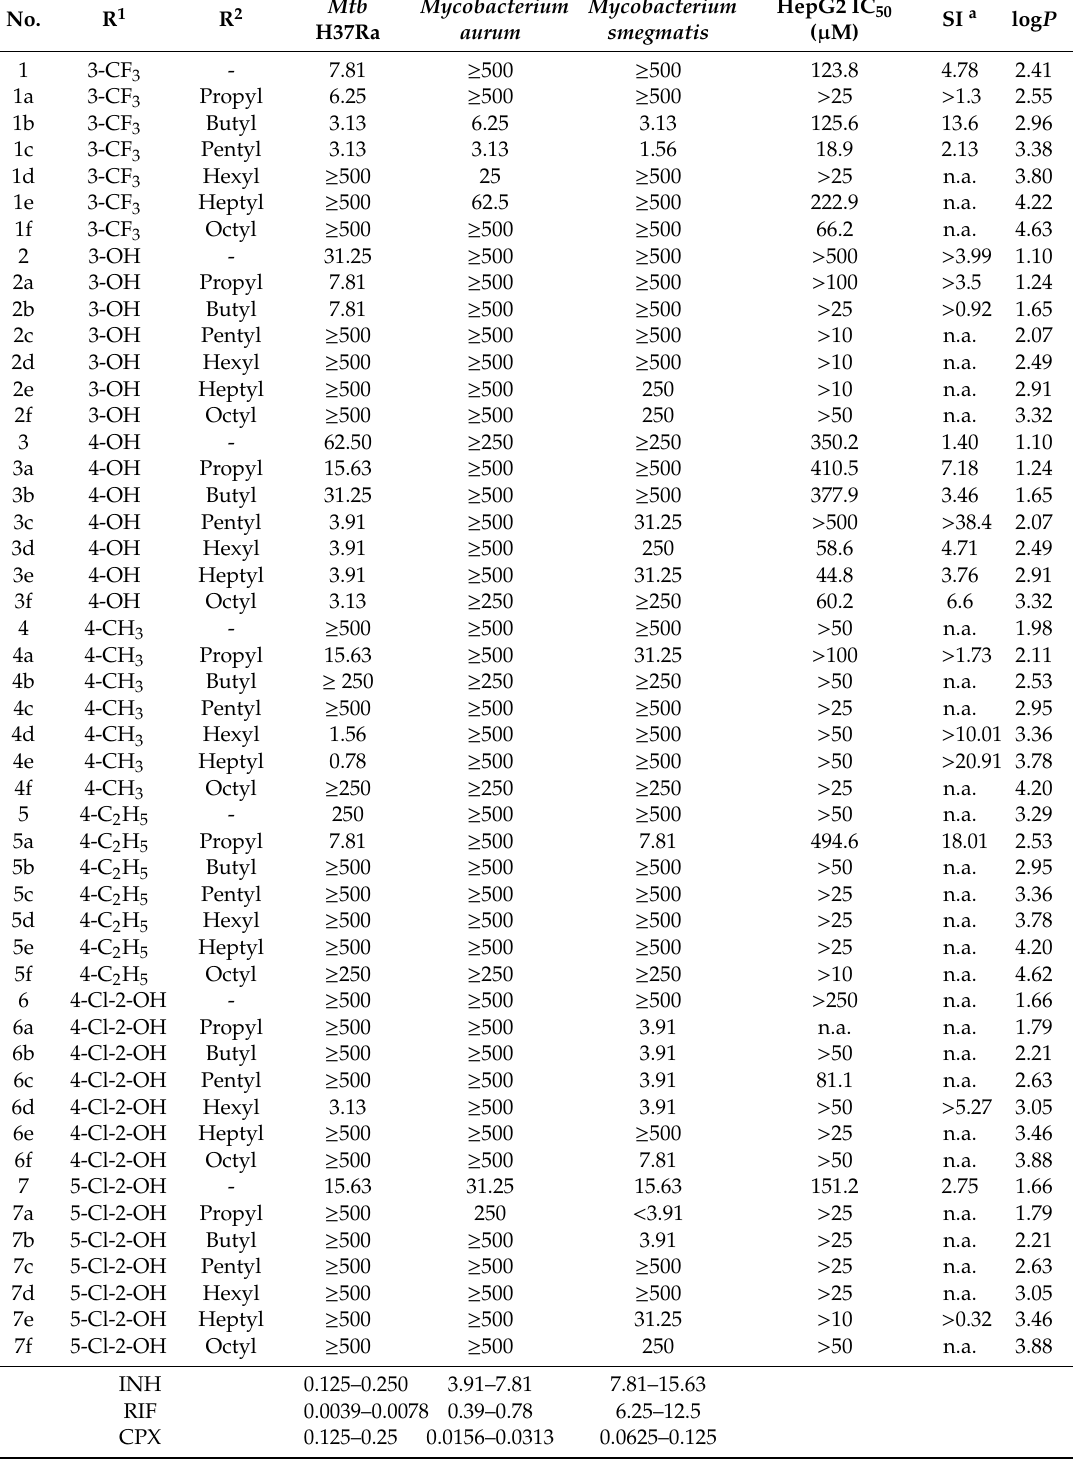
Table 1. In vitro antimycobacterial activity against Mtb H37Ra, Mycobacterium aurum and M. smegmatis (MIC in µ g / mL), cytotoxicity (IC 50 ), selectivity index (SI), and calculated lipophilicity (log P )